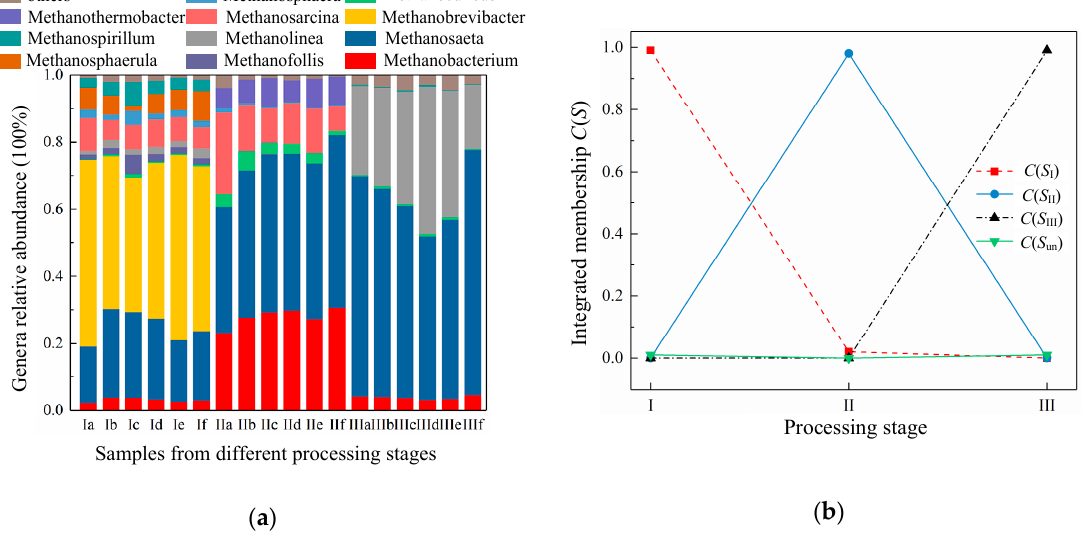
Figure 6. Variation of x values and integrated memberships of di ff erent sludge-processing stages: ( a ) Relative abundance of di ff erent genera of methanogens (letters a to f represent the six paralleling sludge samples from one stage, roman numerals I, II, and III represent Stage I, Stage II and Stage III of the three-stage sludge-treatment process); ( b ) Integrated memberships of di ff erent processing stages. (Stage I stands for the state of sludge samples after treated by centrifugal thickening and pre-dewatering, Stage II stands for the state of sludge samples after treated by thermal hydrolysis, Stage III stands for the state of sludge samples after experiencing anaerobic digestion, and stage uncertain stands for the uncertainty of the processing stage a ffi liation of a sludge sample.)